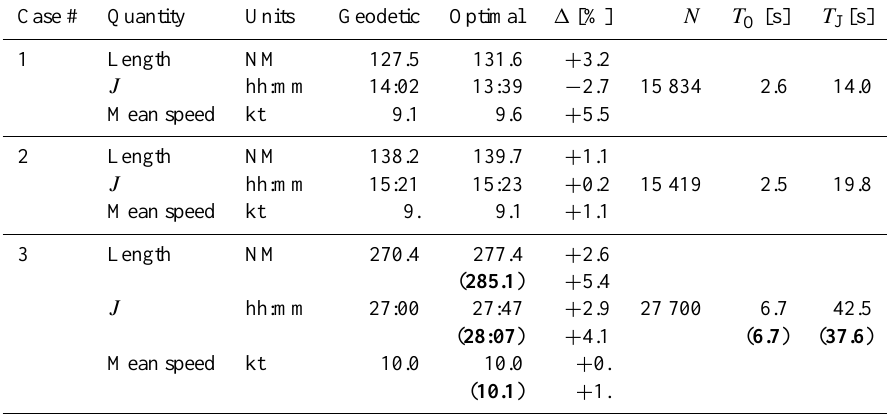
Table 11. Summary metrics for the case study routes displayed in Figs. 10–15. Values in bold between brackets for case study #3 refer to the optimal route without voluntary speed reduction (engine throttle forced to always be 100%). Variations are computed as (cid:49) 1 ) . N is the number of sea nodes found in the bounding box selected for the computations; T O is the time spent in the computation of the optimal route; while T J is the total job computing time (excluding rendering of maps and time series). T J is shorter in case voluntary speed reduction is not applied, since edge weights have to be evaluated at just a single engine throttle. T O and T J refer to the performance